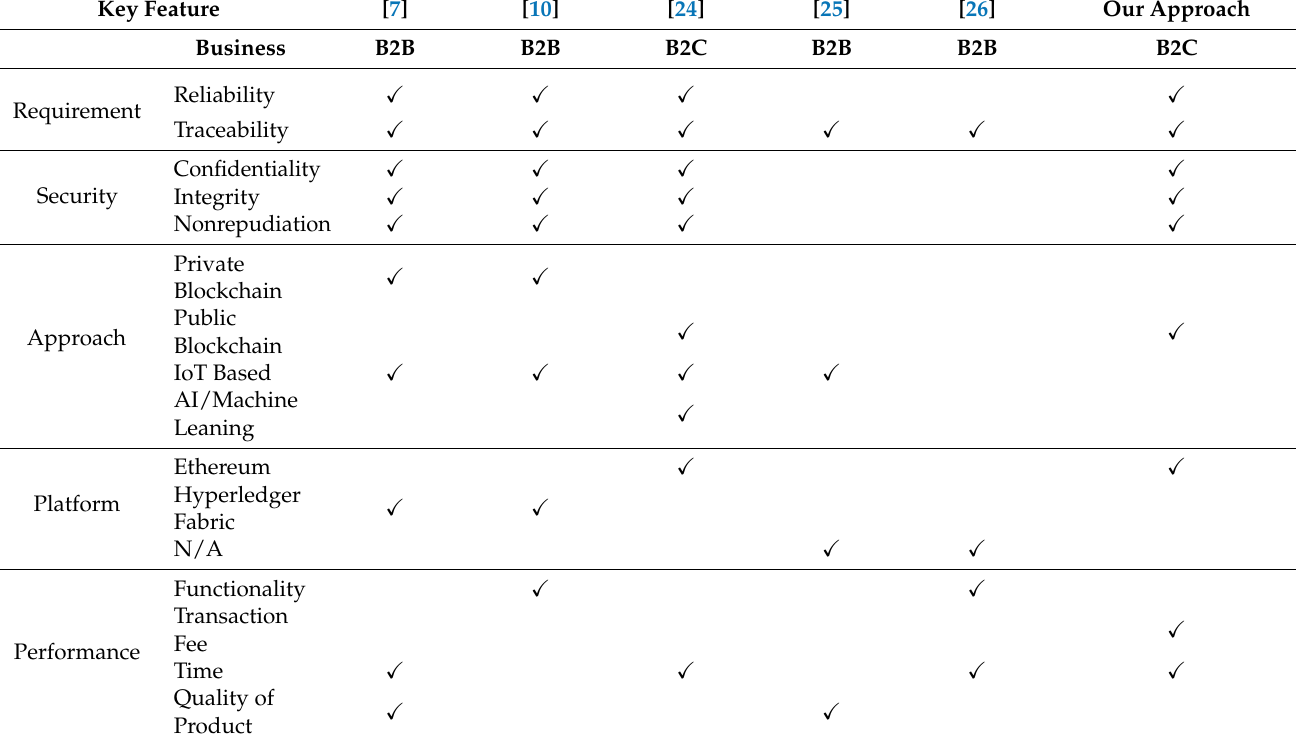
Table 1. Related work on the application of blockchain in smart